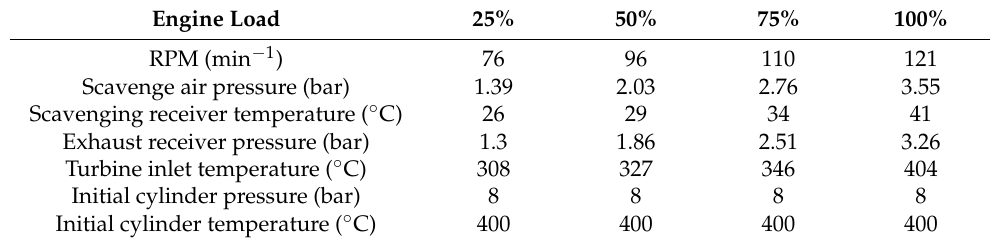
Table 3. Simulation boundary conditions and initial